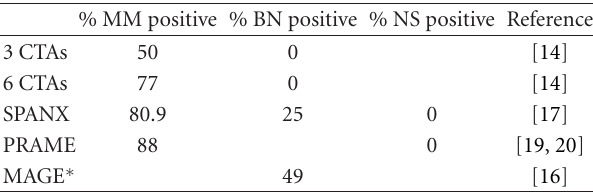
Table 1: CTA diagnostic potential.